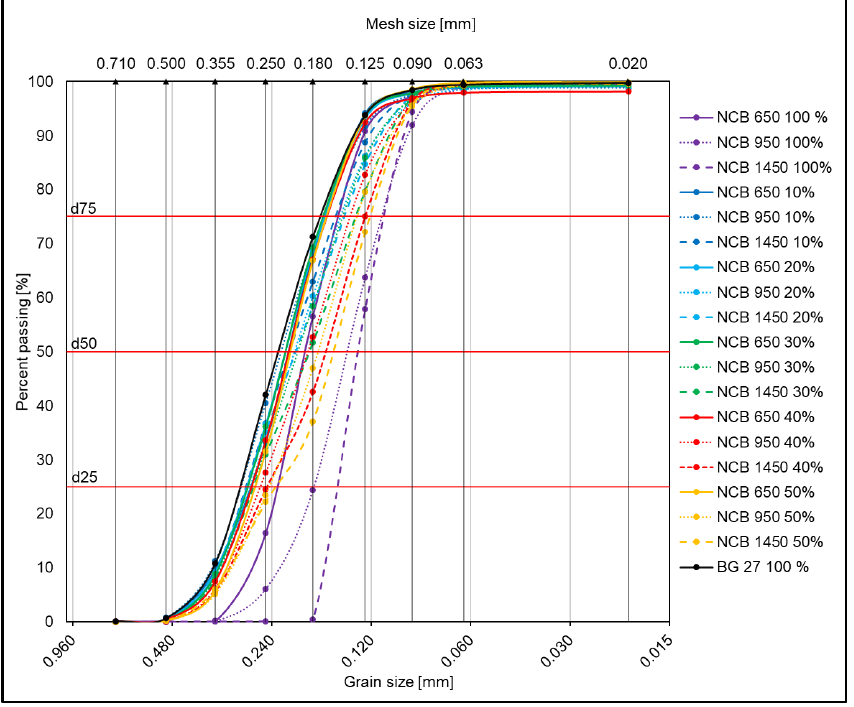
Figure 3. Cumulative curves of granularity for all pure and hybrid sands with various NCB con- tents.